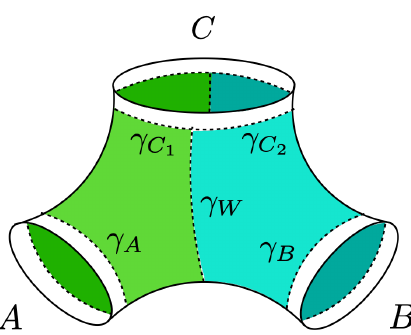
and the non-trivial EW A/B/C and γ simultaneously, the W C 1 /C 2